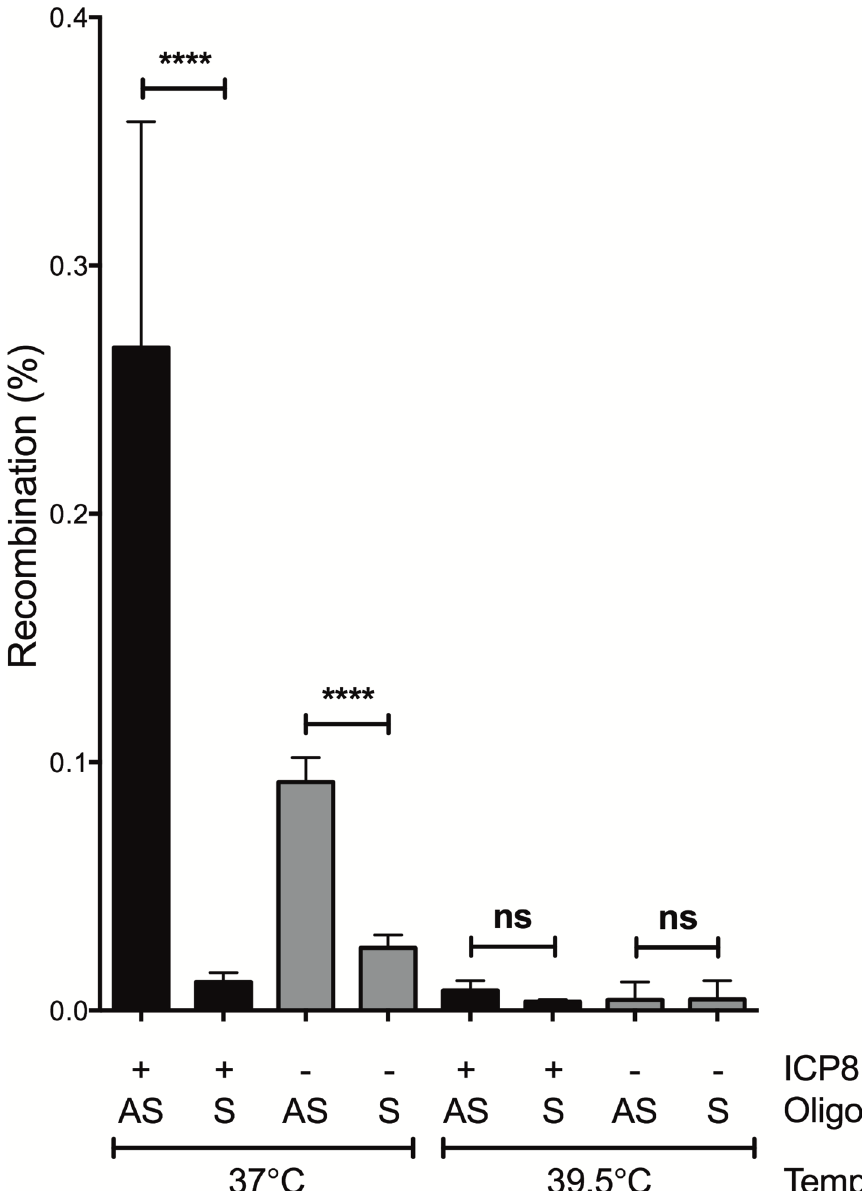
Fig 6. Recombineering strand bias depends on replication originating from the SV40 origin in the integrated lentiviral transgenic target. Recombination was measured in pSLIK4 and pSLIK6 lines using antisense or sense oligos. Cells were grown either at 37˚C (T antigen active), or at 39.5˚C (T antigen does not bind to or promote replication from the SV40 origin). Fisher’s Exact Test was used to evaluate statistical significance with (cid:3)(cid:3)(cid:3)(cid:3) indicating P < 0.001 and ns indicating P > 0.05. n =